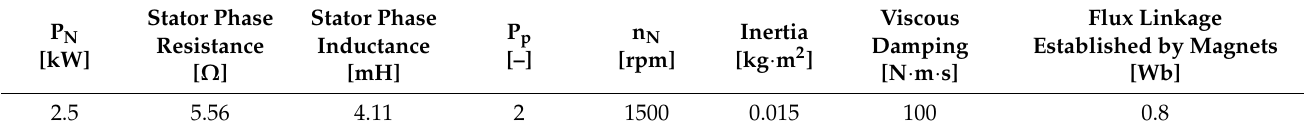
Figure 2. General diagram of scalar control system ( a ) and field-oriented control ( b ) with space vector modulation (SVM), where i sA , i sB , i sC —phase currents, i s α , i s β —stator current components, i sd , i sq —stator currents components in rotor frame. Table 1. Parameters of motor used in